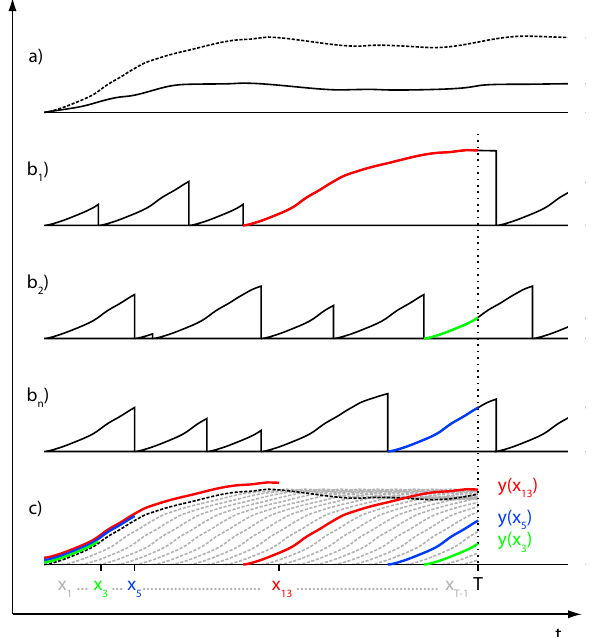
Fig. 1. Principle of GAPPARD. Development of any vegetation Fig.1. PrincipleofGAPPARD.Developmentofanyvegetationstatevariable(e.g. biomassofaspecies)yover state variable (e.g., biomass of a species) y over time t . (a) solid time t. a) solid line: average development with disturbances; dashed line: development without disturbances. line: average development with disturbances; dashed line: develop- b 1 - b n ) development of the state variable for patch 1 to n, stand-replacing disturbances appear with disturbance ment without disturbances. ( b 1 – b n ) development of the state vari- able for patch 1 to n , stand-replacing disturbances appear with dis- probability p. c) necessary information to calculate y with the GAPPARD method at time T. For years x 1 to x T − 1 the same development of y is applied. turbance probability p . (c) necessary information to calculate y with the GAPPARD method at time T . For years x 1 to x T − 1 , the same development of y is